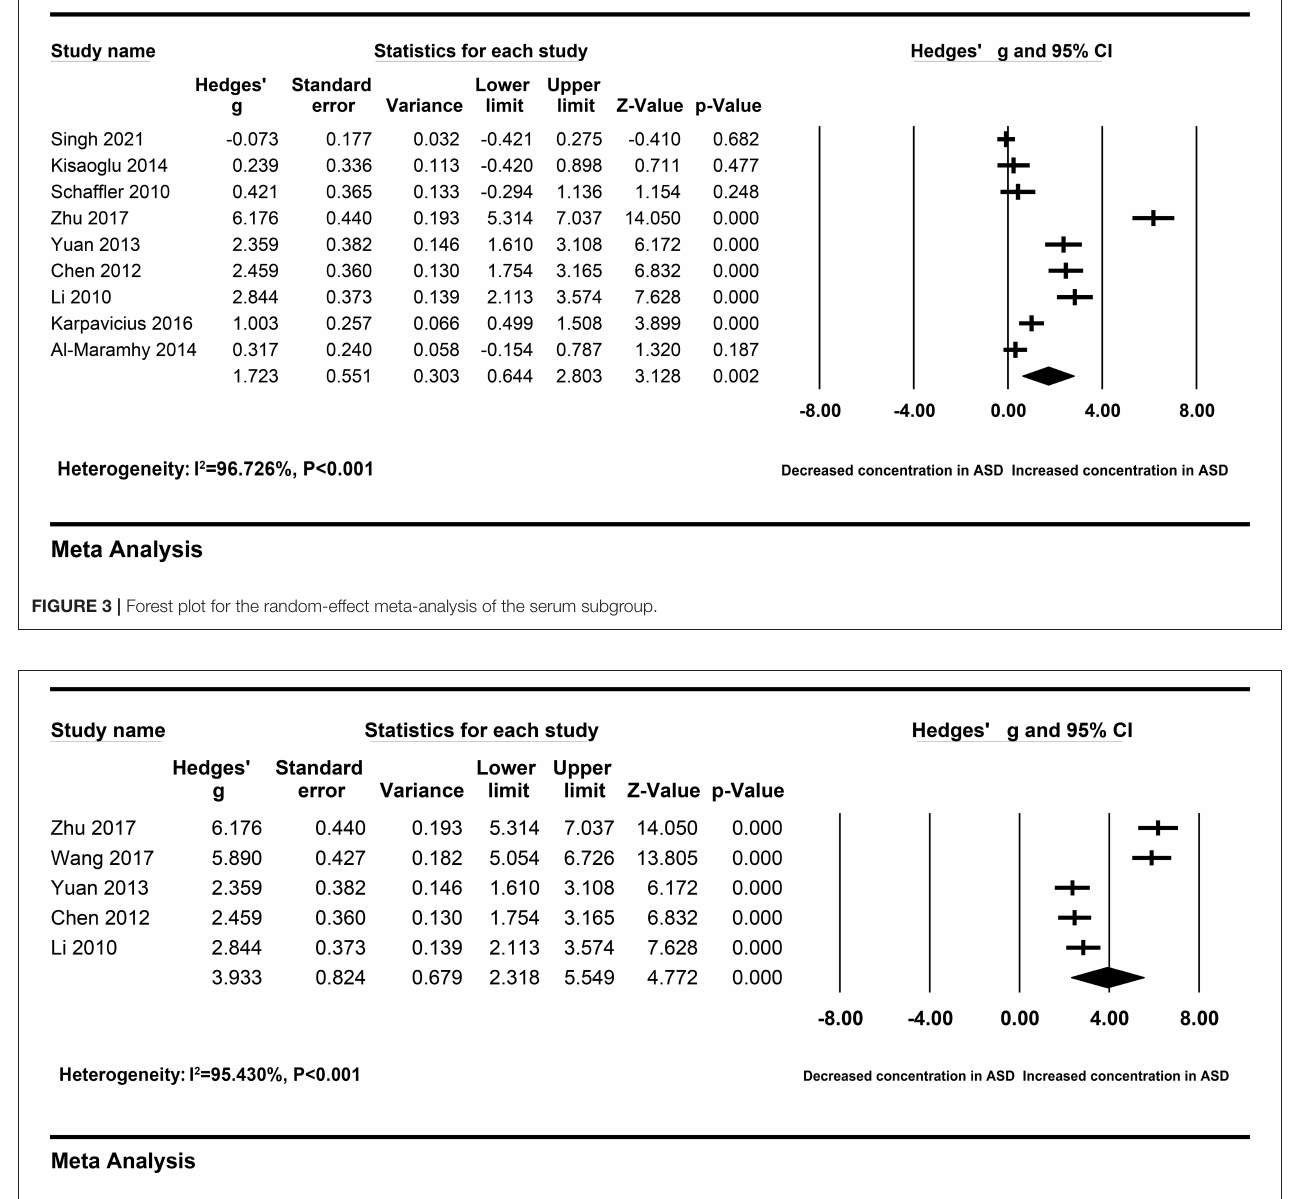
FIGURE 4 | Forest plot for the random-effect meta-analysis of the Chinese